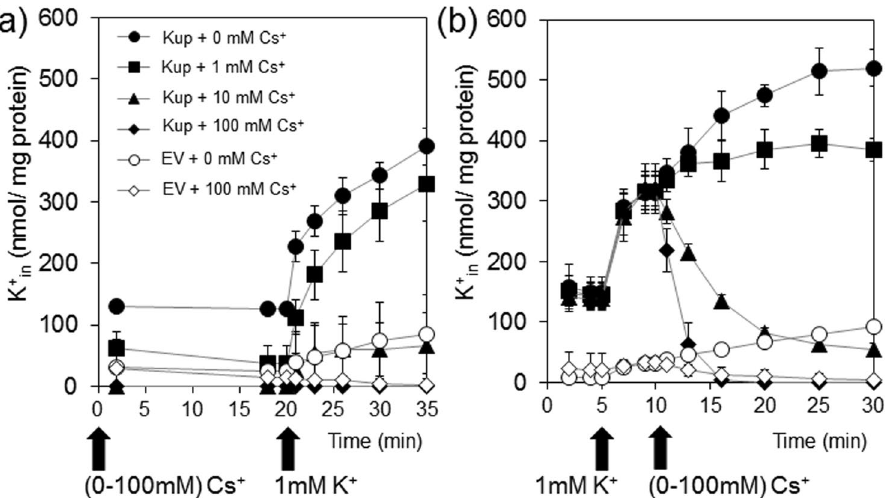
Figure 4. High concentrations of Cs + reduced K + content in cells expressing Kup. Cs + (0, 1, 10 or 100 mM) was added 20 min before ( a ) or 5 min after ( b ) K + addition (1 mM final concentration). The error bars represent mean ± S.D. (n = 3). Filled and open symbols represent E . coli LB2003 transformed with Kup and EV,